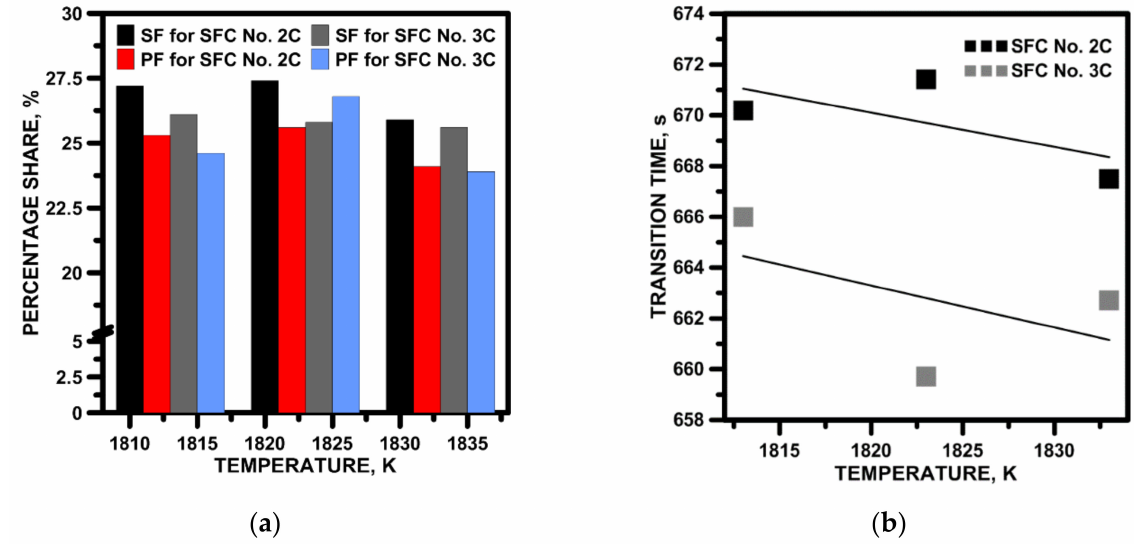
Figure 13. Influence of liquid steel initial temperature: ( a ) influence on stagnant flow (SF) and plug flow (PF), ( b ) influence on transition